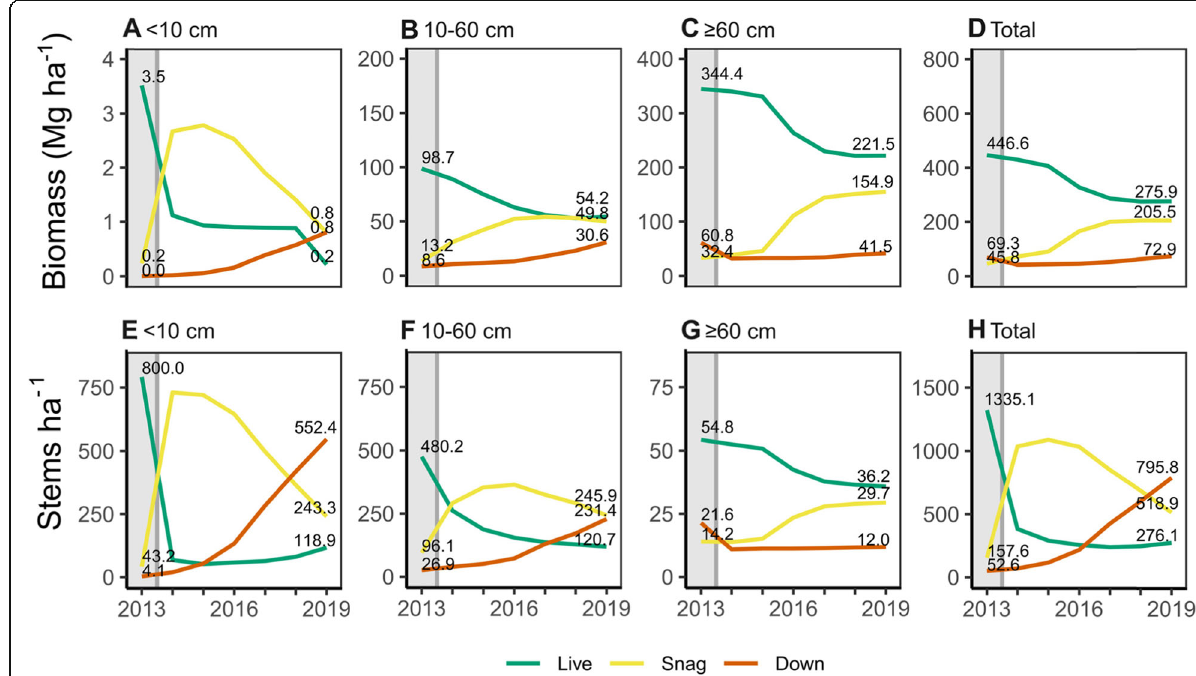
Fig. 7 Cumulative standing trees (green lines), snags (yellow lines), and deadwood (brown lines) following fire (gray vertical line) in the Yosemite Forest Dynamics Plot from 2013 (pre-fire) to 2019. Trees 1 cm ≤ DBH < 10 cm, 10 cm ≤ DBH < 60 cm, ≥ 60 cm DBH, and all wood are shown in terms of biomass (top panels a , b , c , and d ) and stem density (bottom panels e , f , g , and h ). The gray line indicates the timing of the 2013 Rim Fire. Per-hectare values correspond to the totals in Table